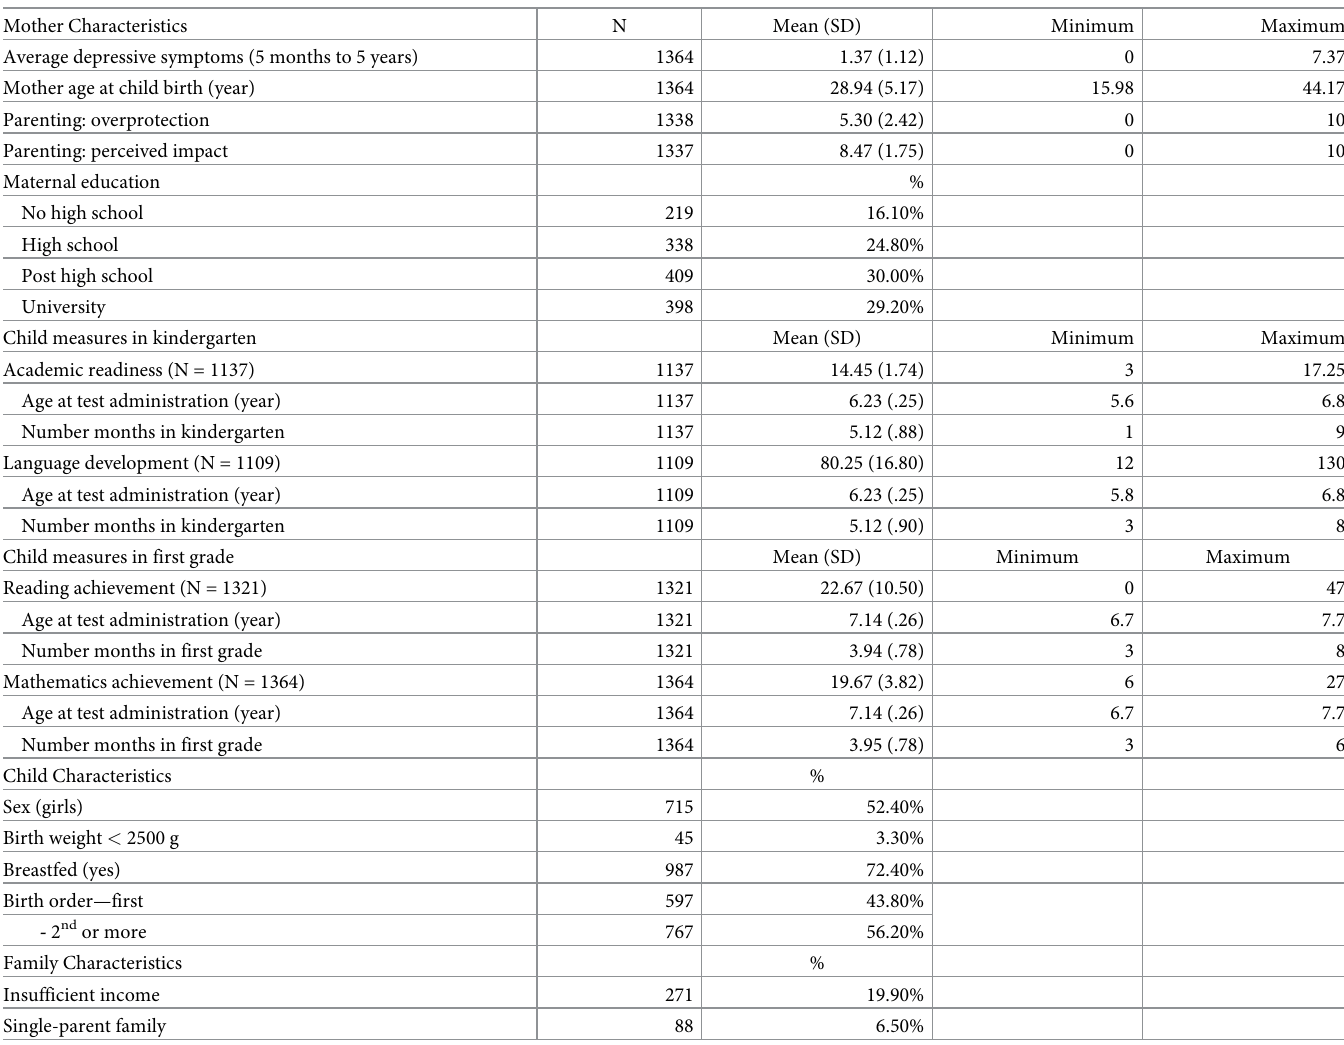
Table 1. Descriptive